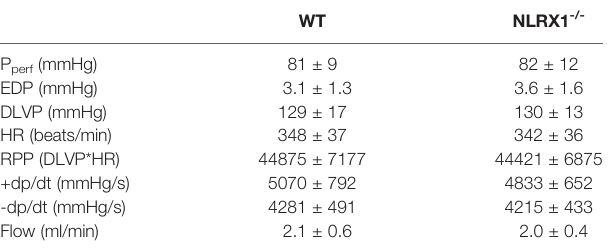
TABLE 1 | Baseline functional values at T0 in WT and NLRX1 -/- isolated mouse hearts from protocols 1 to 5. WT NLRX1 -/- P perf (mmHg)